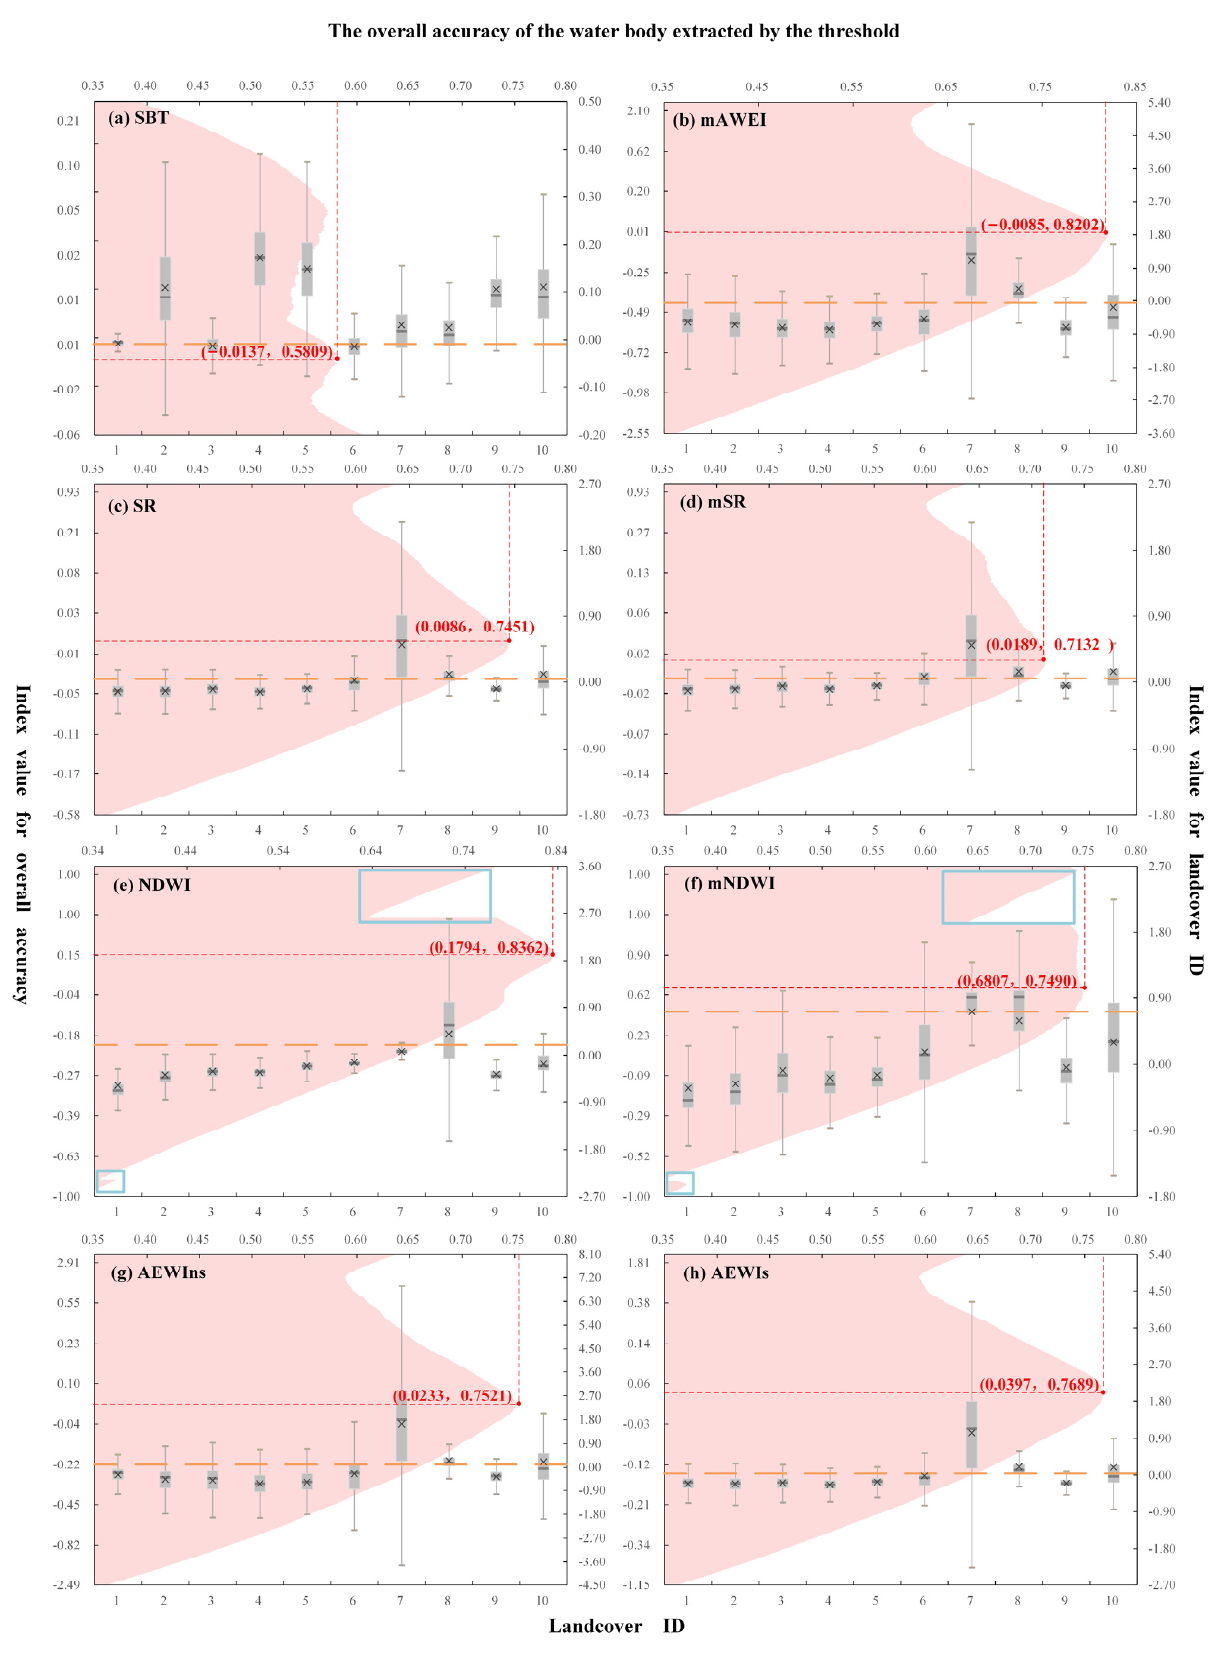
Figure 6. The threshold segmentation extracts the overall accuracy of the waterbody. The bottom X-axis represents the landcover code (as shown in Table 1), corresponding to the Y-axis on the right and the